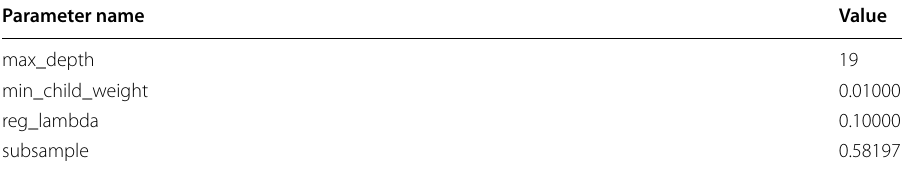
Table 96 Modes of XGBoost tuned hyperparameter values for experiments with the keylogging